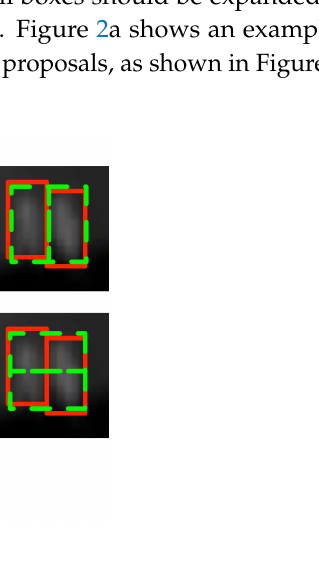
Figure 2. Generating multiple region proposals from a possible location. The red box refers to the groundtruth, green solid box refers to the extracted possible location, and green dash boxes refer to the generated region proposals. ( a ) and ( b ) illustrate two examples of generating region proposals by splitting and expanding original region proposals,